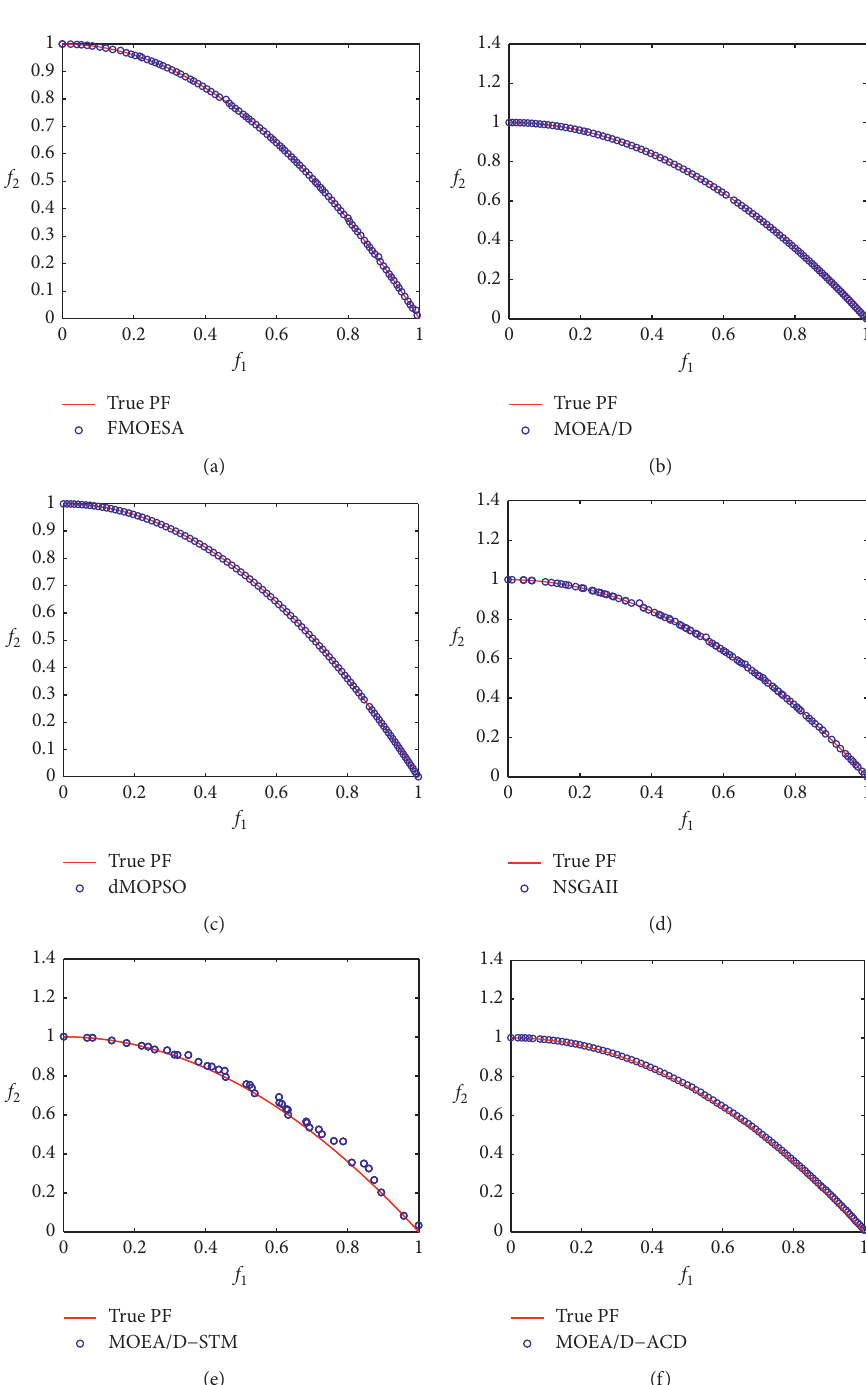
Figure 1: The approximate front of FMOESA, MOEA/D, dMOPSO, NSGAII, MOEA/D-STM, and MOEA/D-ACD on ZDT2. (a) FMOESA, (b) MOEA/D, (c) dMOPSO, (d) NSGAII, (e) MOEA/D-STM, and (f)